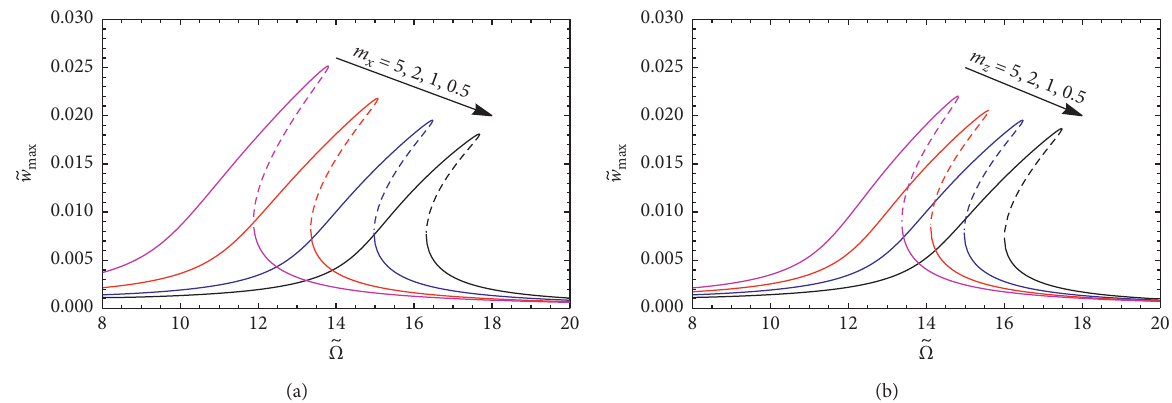
Figure 6: Effect of material gradient parameters m � 0 . 1, L / h � 20, 􏽥 c when α 0